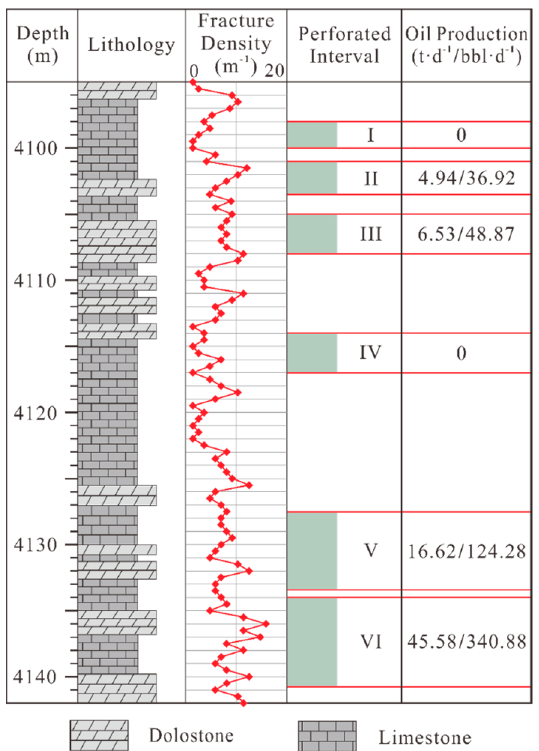
Figure 18. Schematic diagram showing the lithology combination, fracture density, perforated interval, and oil production in Well R10. Oil production refers to the daily production of oil in the well-testing stage. Lithology and fracture data were derived from the borehole image logs, and the data pertaining to perforated intervals and oil production were collected from the Huabei Oilfield database. I to VI refer to the name of perforated intervals, which correspond to the names also shown separately in Figure 19. Unit t·d − 1 refers to the average number of tons of oil produced per day.